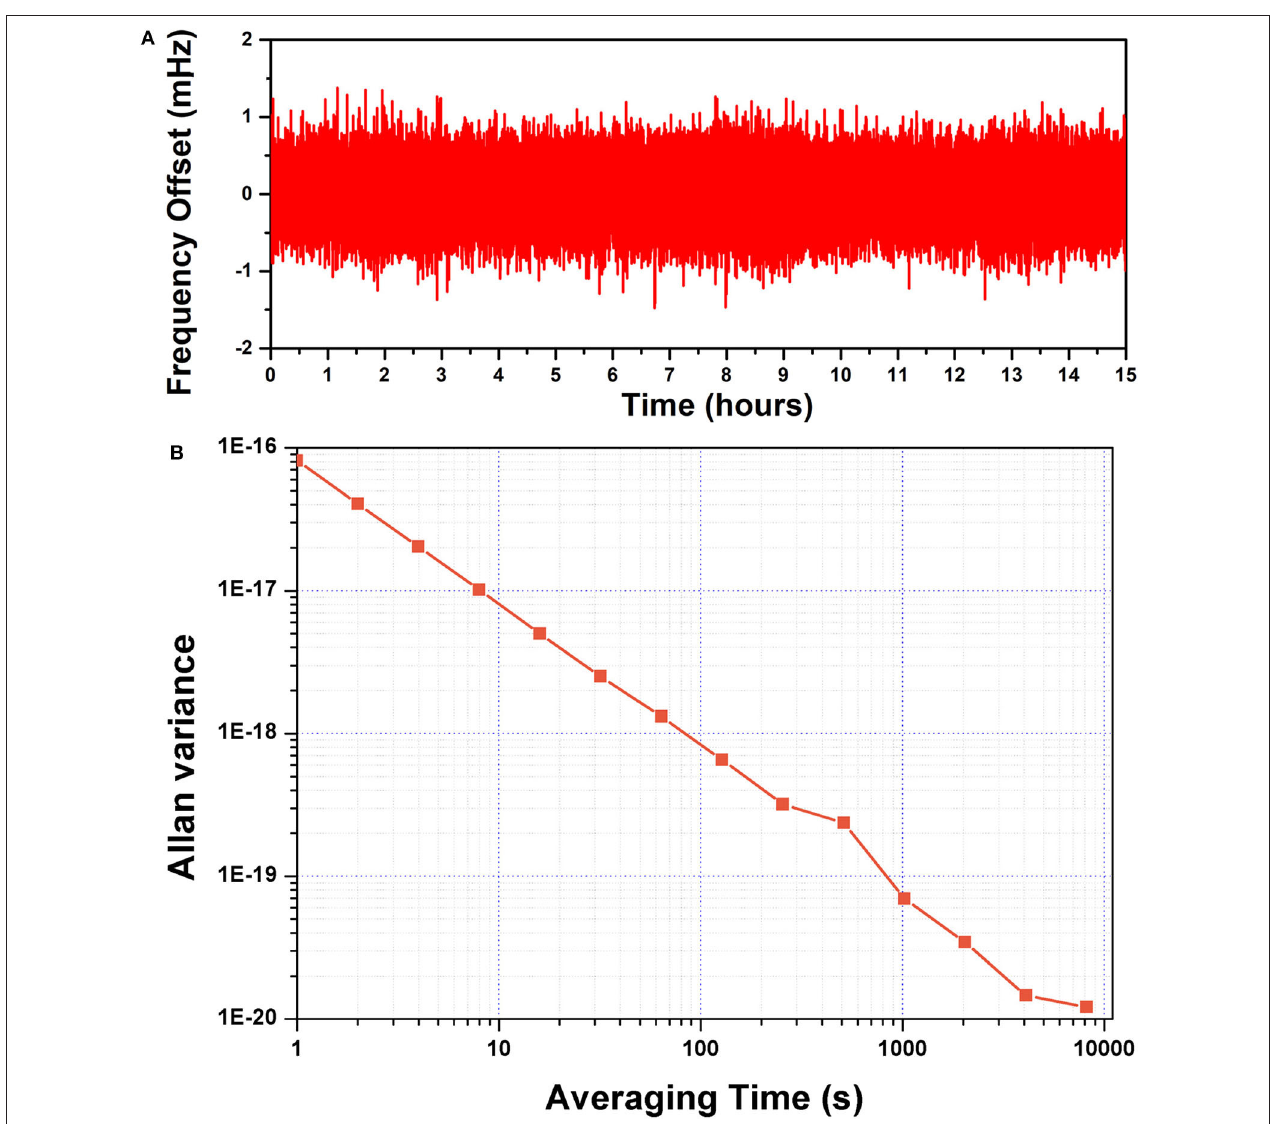
FIGURE 3 | (A) Frequency deviation of f ceo for 15h and (B) Allan deviation of f ceo